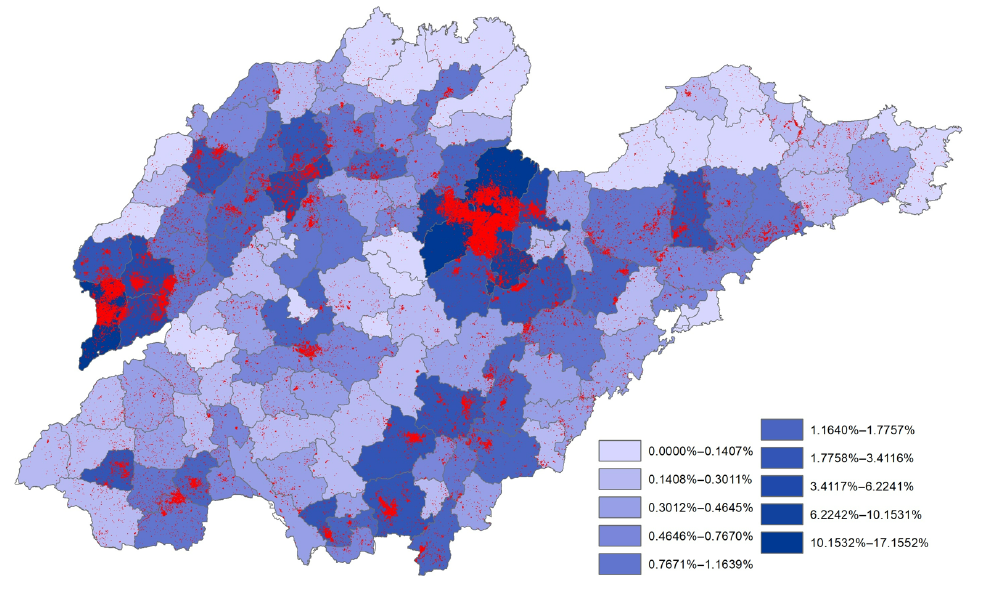
Figure 7. Mapping results of greenhouses from 2.38 m satellite imagery in Shandong Province, China, based on the proposed architecture. Red pixels represent a greenhouse. Blue areas of different intensities represent counties with different greenhouse densities.